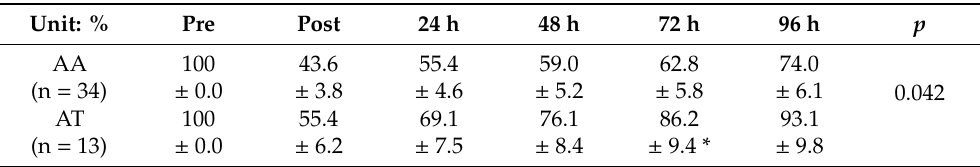
Table 2. Changes in maximal isometric strength (MIS) after eccentric exercise according to the myostatin A55T genotype.